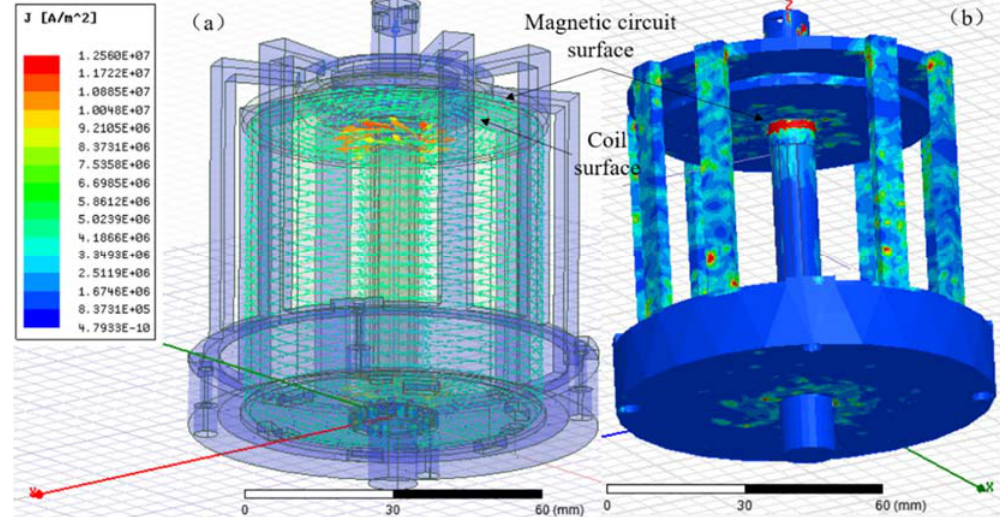
Figure 9. Current density simulation: ( a ) Arrow diagram of current density distribution, ( b ) Hysteresis ohmic loss diagram.